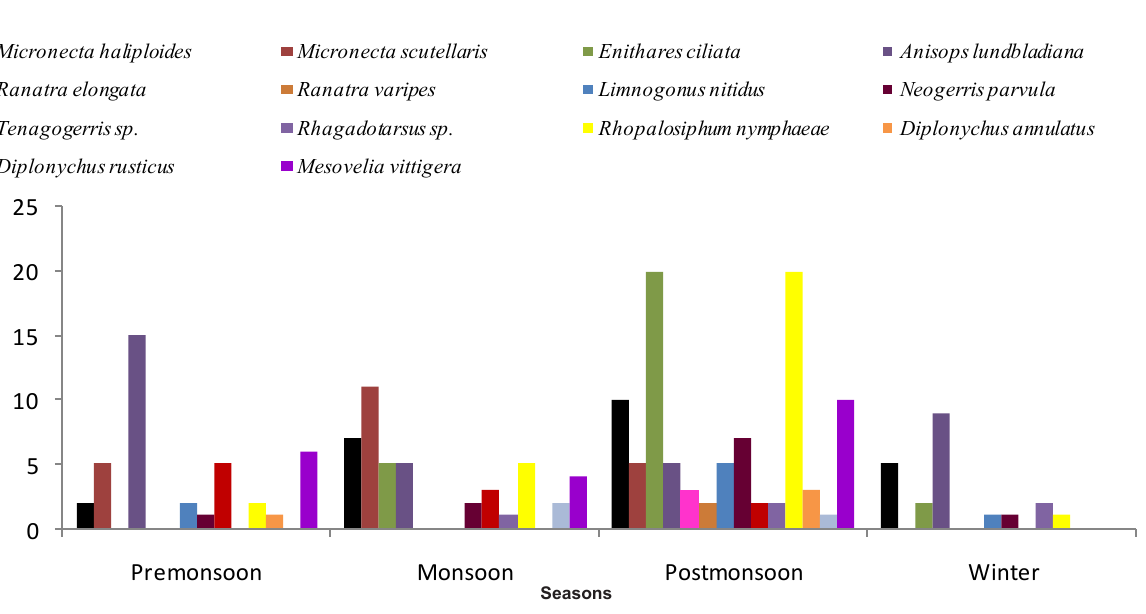
Figure 4. Seasonal variation in density of different species of